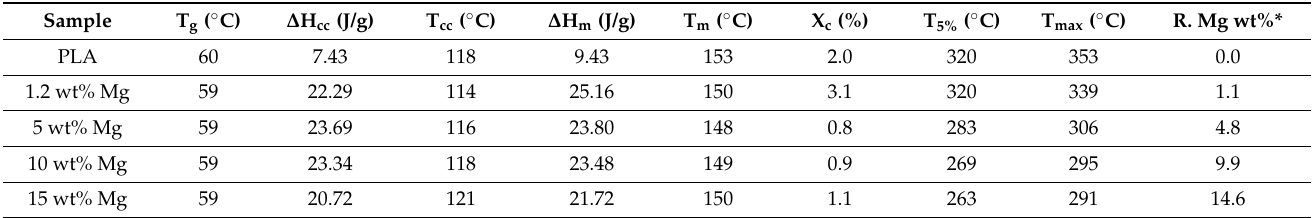
Figure 4. First heating DSC curves for each PLA-Mg filament. Table 1. Thermal properties for each PLA-Mg filament obtained from DSC curves.